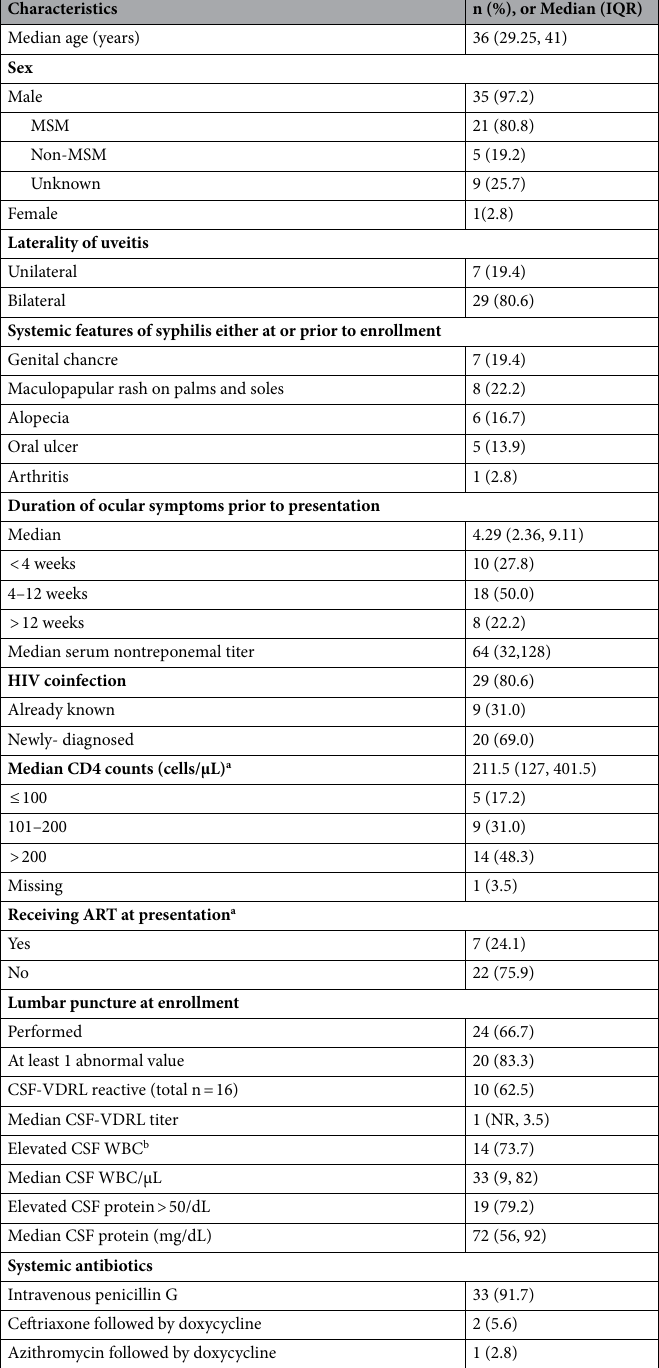
Table 1. Demographic and clinical characteristics of 36 patients with syphilitic uveitis at presentation. a Calculated in HIV-infected patients only. b Considered abnormal if > 5/μL in HIV-uninfected patient, > 20/μL for HIV-infected patient. ART: antiretroviral therapy; CSF: cerebrospinal fluid; MSM: men who have sex with